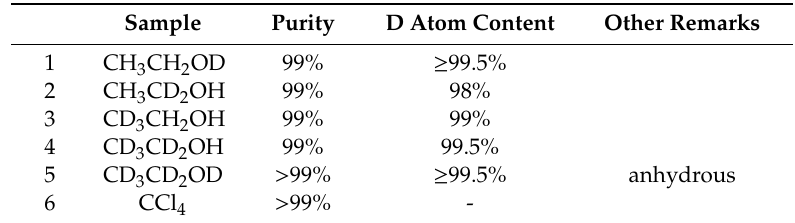
Table 11. Samples used in this